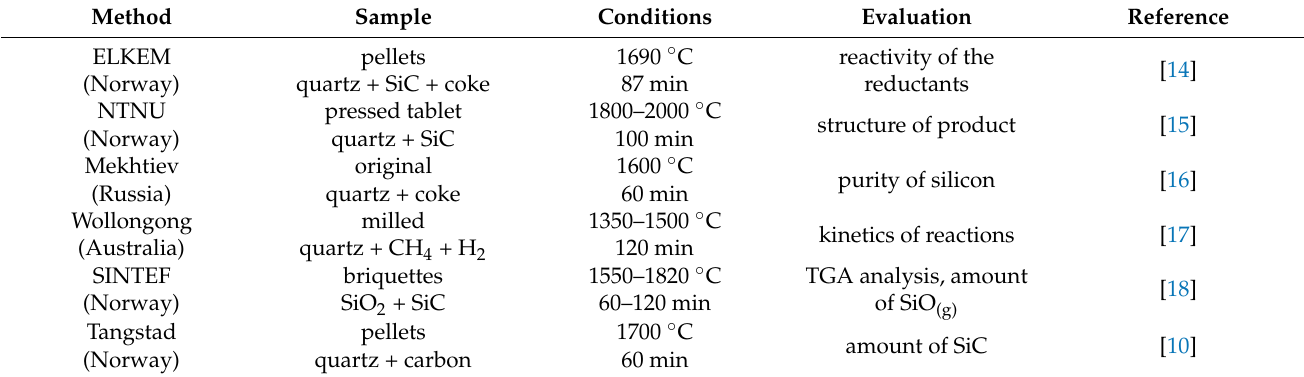
Table 3. Methods for determining the reducibility of quartzes (or quartzites) [10,14–18]. Method